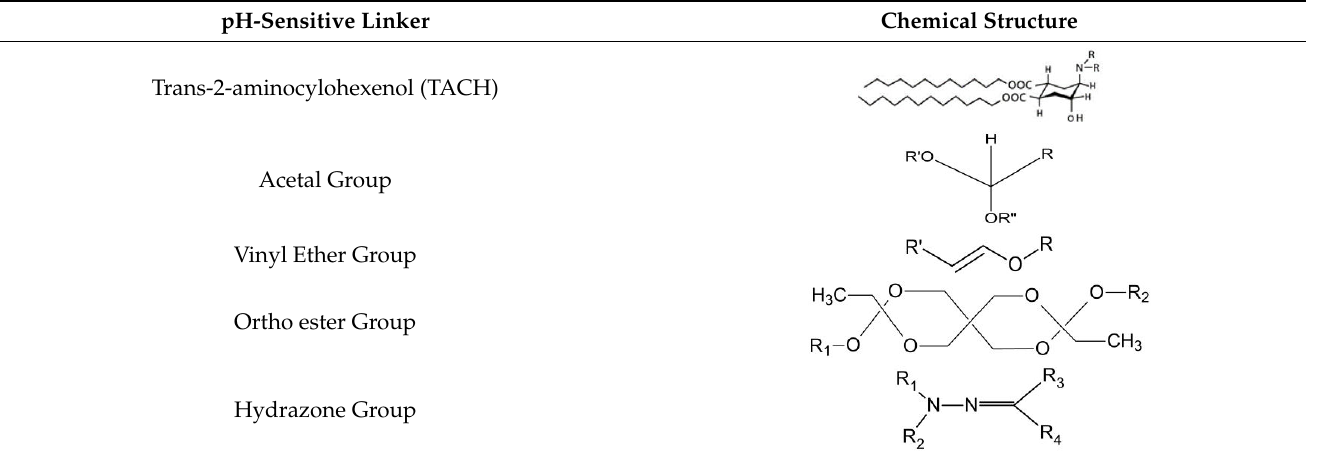
Table 3. Commonly used pH-sensitive linkers and their structures.